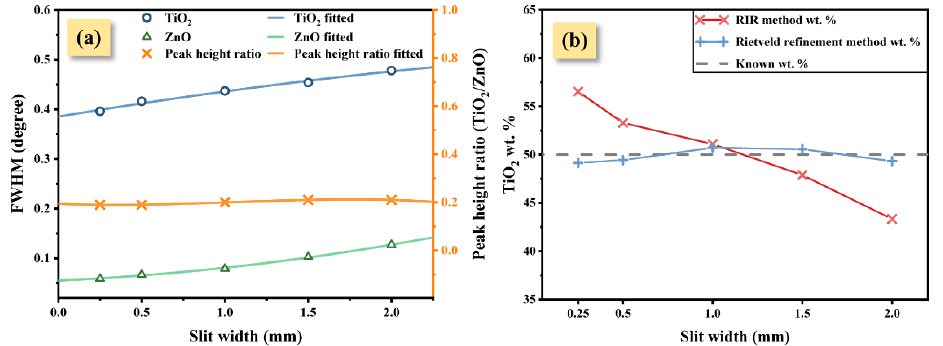
Figure 5. The change curve of the FWHM and height ratio of the strongest peaks ( a ) and quantitative result of RIR and Rietveld refinement method ( b ) under five slit widths.